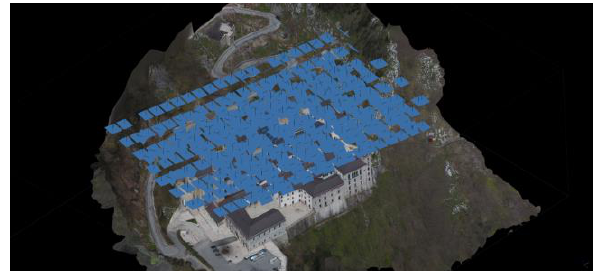
Figure 3. Acquisition of photographic datasets